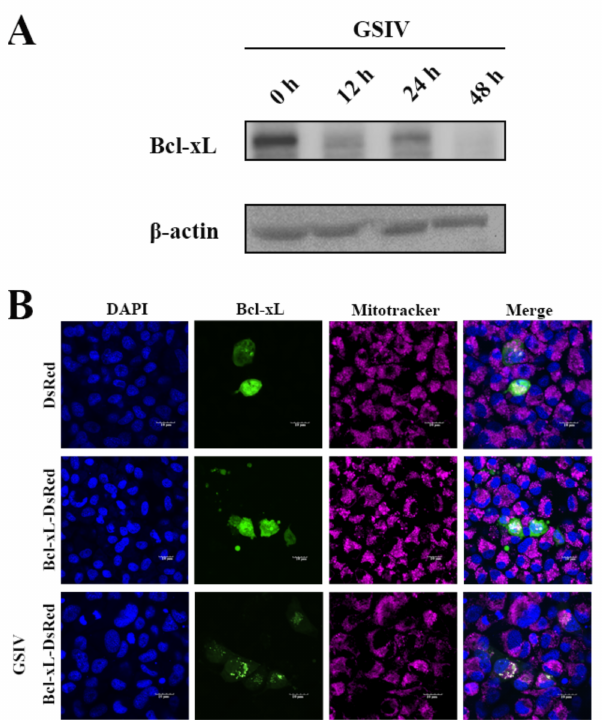
Figure 2. Expression and subcellular localization of AdBcl-xL after Chinese giant salamander iridovirus (GSIV) infection. ( A ) Levels of the AdBcl-xL protein at 0, 12, 24, and 48 h post GSIV infection, as assessed using Western blotting. ( B ) Cytoplasmic localization of AdBcl-xL in transfected GSM cells at 24 h post GSIV infection, as assessed using confocal microscopy. GSM cells were transfected with pDsRed-Monomer-N1-AdBcl-xL or pDsRed-Monomer-N1; mitochondria were stained with mitochondrion-selective probes; and nuclei were stained using DAPI at 48 h post transfection. Scar bar, 10 µ